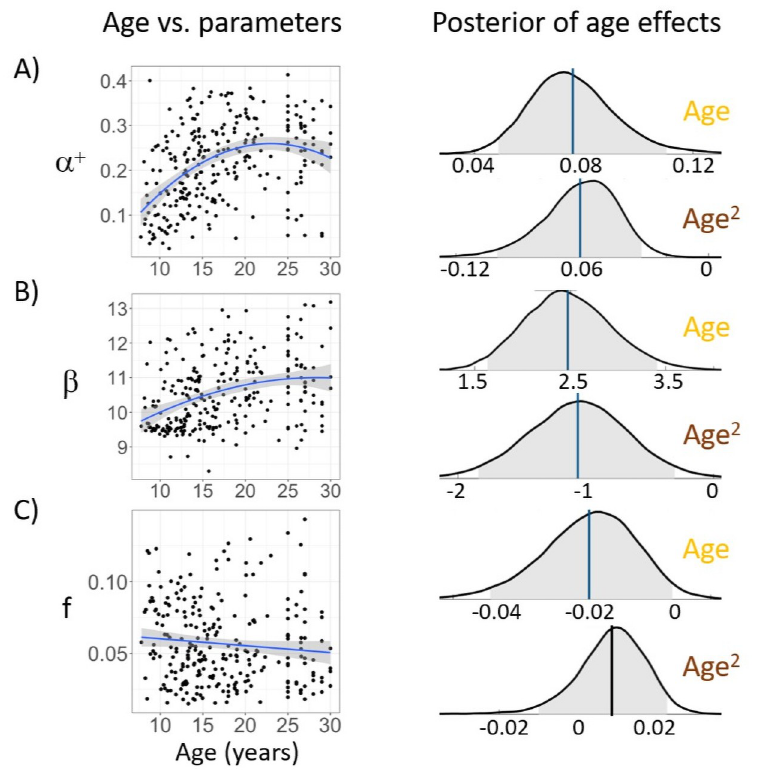
Fig 4. Age effects on model parameters. We directly incorporated age-related parameters into MCMC sampling to test within the hierarchical Bayesian modeling framework whether age had a linear or quadratic effect on all three model parameters: α + (A), β (B), f (C). Left panel: individual parameters from the original α + 0 β f model plotted against age. For visualization, we included a regression line; the shaded region indicates 95% CI. Right: distribution of posterior samples for linear (top, yellow) and quadratic (bottom, brown) regression coefficients. The vertical line represents the mean of all samples, with blue indicating an effect being present (i.e., 95% CI not including 0), and black indicating no effect. Shaded region shows 95% confidence